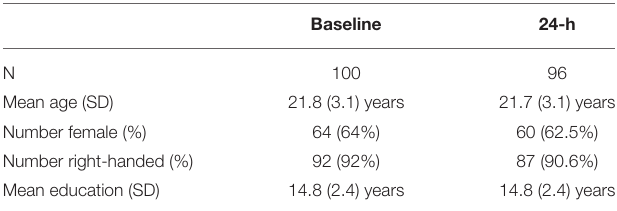
TABLE 2 | Participant demographic information for healthy adults completing the DalCAB at the baseline and 24-h testing